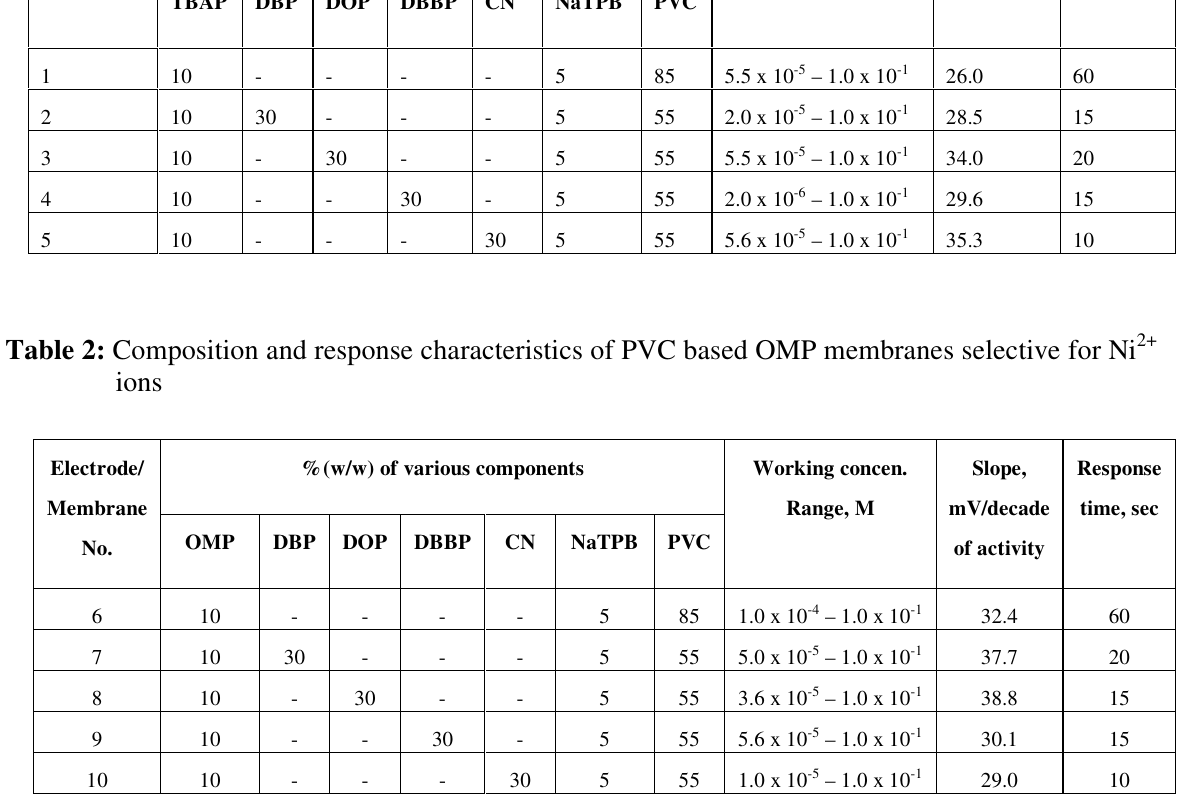
Table 1: Composition and response characteristics of PVC based TBAP membranes selective for Ni 2+